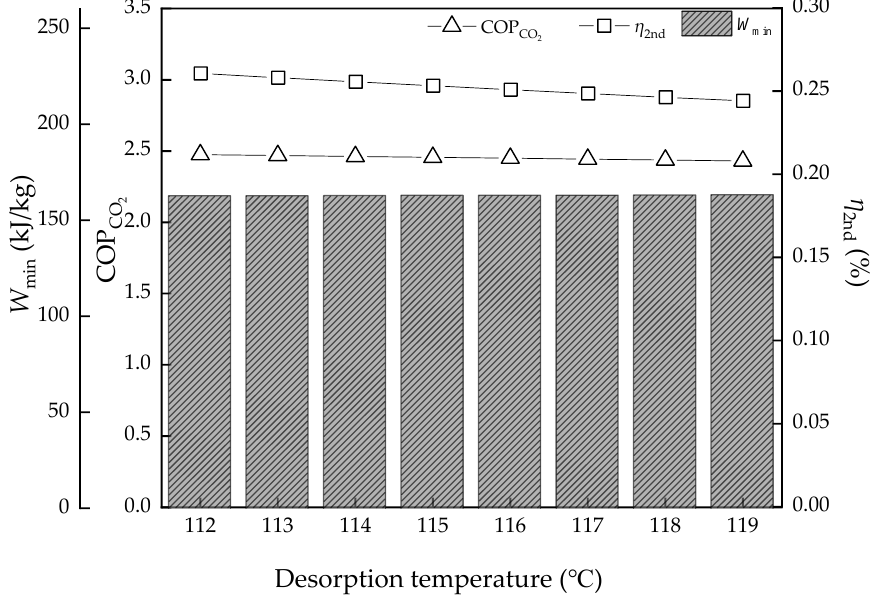
Figure 11. The energy efficiency performance with the desorption temperature variation.